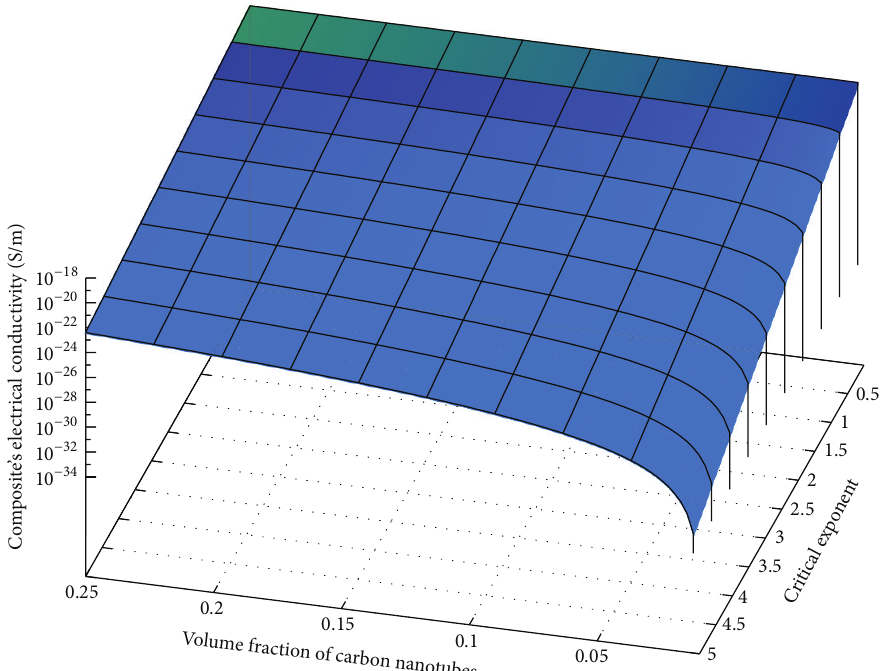
Figure 7: DC electrical conductivity of the nanocomposite at varying both the critical exponent of the percolation and the volume fraction of the filler (Kirkpatrick’s model).